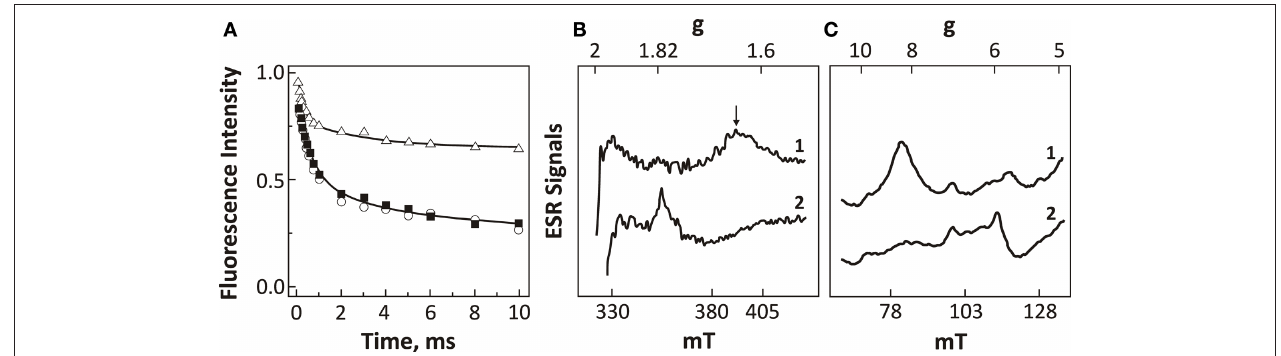
FIgurE 9 | Fluorescence and EPr data representing the effects of HC (spectrum 1) and the presence of 100 mM formate (spectrum 2). The used removal on the electron-acceptor side of PSII. (A) Fluorescence concentration of formate (100 mM) has been shown to be sufficient for the measurements reflecting the decay of Q A − , upon illumination of thylakoids of removal all HC bound to PSII (Govindjee et al., 1991b; Shevela et al., 2008b). Synechocystis 6803 after the third flash (repetitive rate of 1 Hz) at pH 7.5 (C) EPR spectra of the g = 6 non-heme iron region of the dark-adapted PSII (modified and reproduced from Cao and Govindjee, 1988). The fluorescence samples from spinach at pH 7.5. The spectra were obtained in the absence decay was measured in control (i.e., HC-containing) samples (closed (spectrum 1 ) and the presence of 100 mM formate (spectrum 2). For EPR squares), HC-depleted samples (open triangles), and HC-depleted samples settings, see Nugent et al. (1988). Abbreviations: g , is the electronic splitting − . (B) EPR spectra of the iron– after the re-addition of 2.5 mM HCO factor (in case of free electron g -factor, it has a value of 2.0023); mT 3 semiquinone in the dark-adapted PSII samples from thermophilic (millitesla), values for the magnetic field. (B,C) were modified and reproduced cyanobacterium P. laminosum upon 5 min illumination at 77 K in the absence from Nugent et